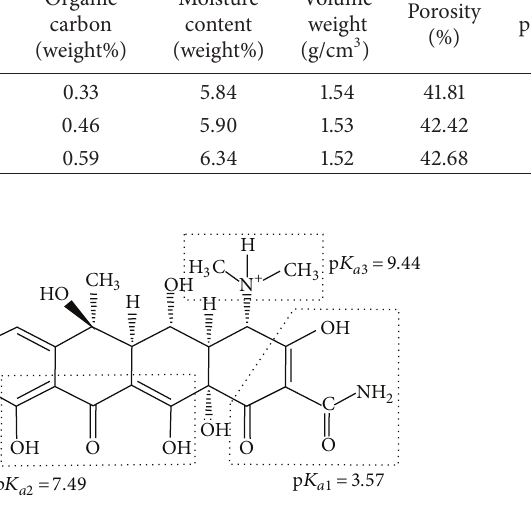
Figure 2: Molecular structure and p 𝐾 𝑎 values of OTC